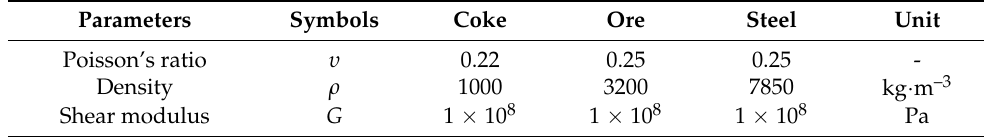
Table 4. Material properties of blast furnace materials.